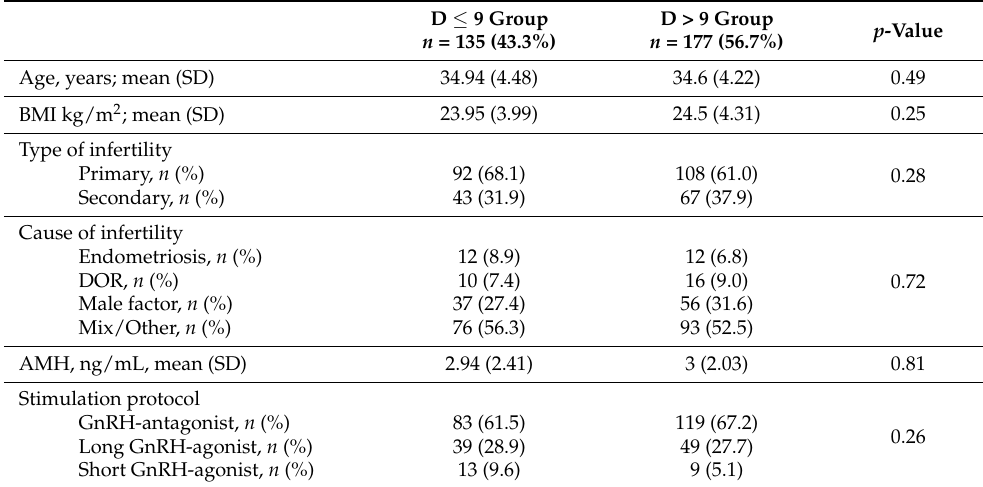
Table 1. Characteristics of patients with ovulation trigger criteria present beginning from the eightth day of ovarian stimulation and with final ovulation trigger performed before or on the ninth day of stimulation (D ≤ 9) or after the ninth day of stimulation (D > 9). D ≤ 9 Group D > 9 Group n = 135 (43.3%) n = 177